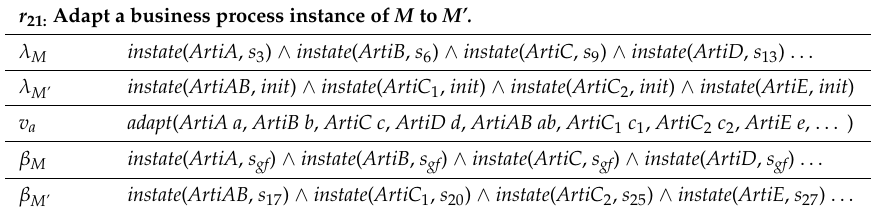
Table 2. The adaptation rule of Example